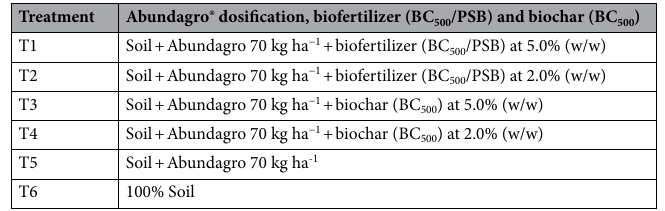
Table 1. Treatments evaluated during the pot experiment.